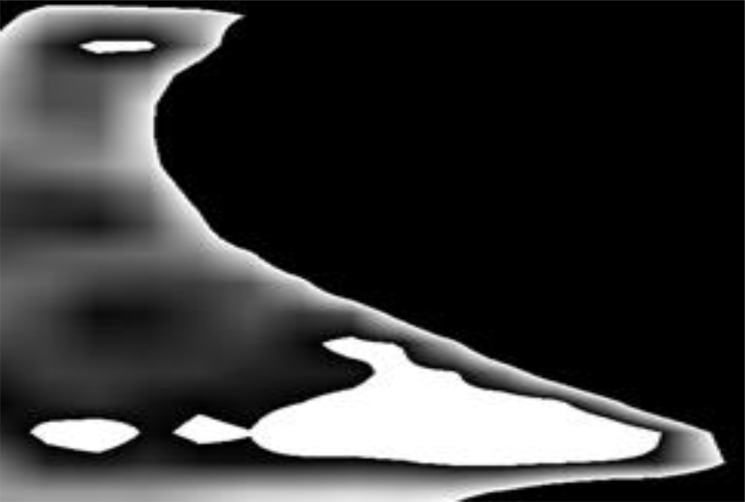
Sagittal view of partially filled cell.A ‘tongue’ of high-density content is visible at the cell opening.